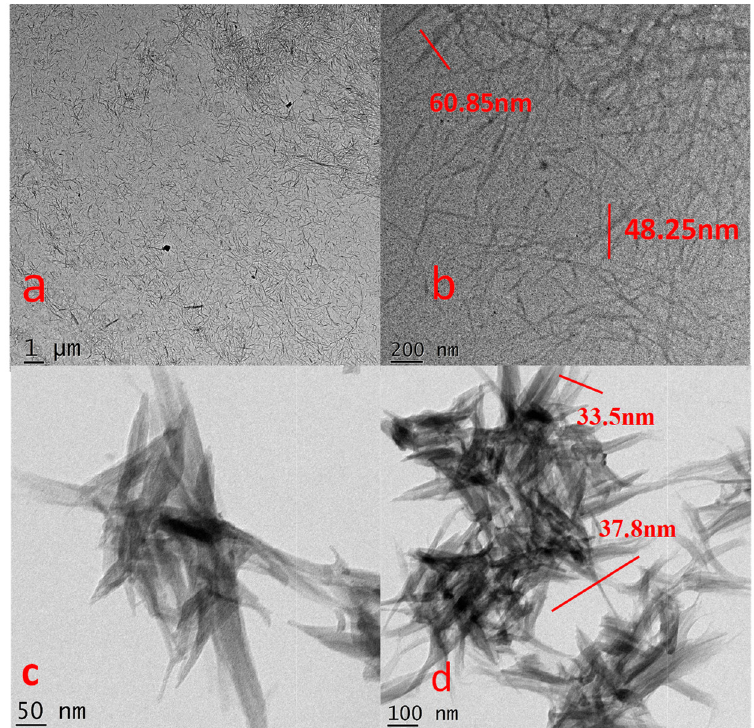
Figure 4. TEM images of ( a , b ) AH-CCNC and ( c , d ) AH-RSNC.